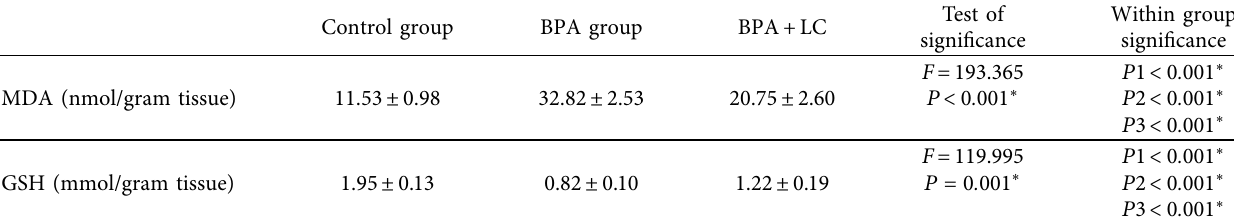
Table 2: Comparison between the study groups regarding MDA and